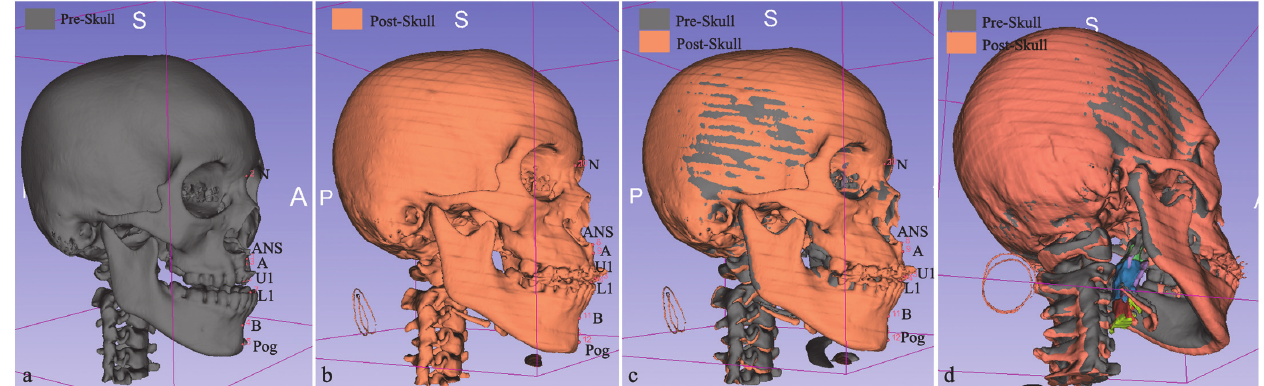
Figure 4. These 3D model images depict the superimposition of pre- and post-skull images, where the pre-skull image shows the 7 points mentioned in ( a ) and the post-skull image shows the 7 points mentioned in ( b ). The overall superimposition image, ( c ), shows the comparison of changes in the skull structure after treatment. ( a ): Pre-Skull, showing 7 points (Point 1: pre-ANS; Point 2: Pre-N; Point 3: